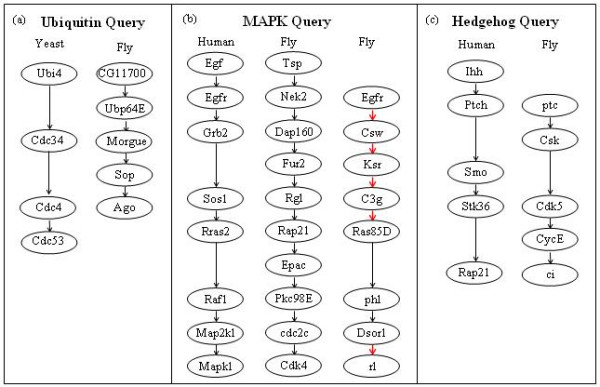
Yeast and human queries and their best-matches in fly. Yeast and human pathway queries and their best-matches in fly. (a) Yeast ubiquitin ligation pathway query in fly. (b) Human MAPK pathway query in fly. The pathway denoted by an asterisk is the result of querying a combined network of PPIs and genetic interactions (appearing in red). (c) Human Hedgehog pathway query in fly.